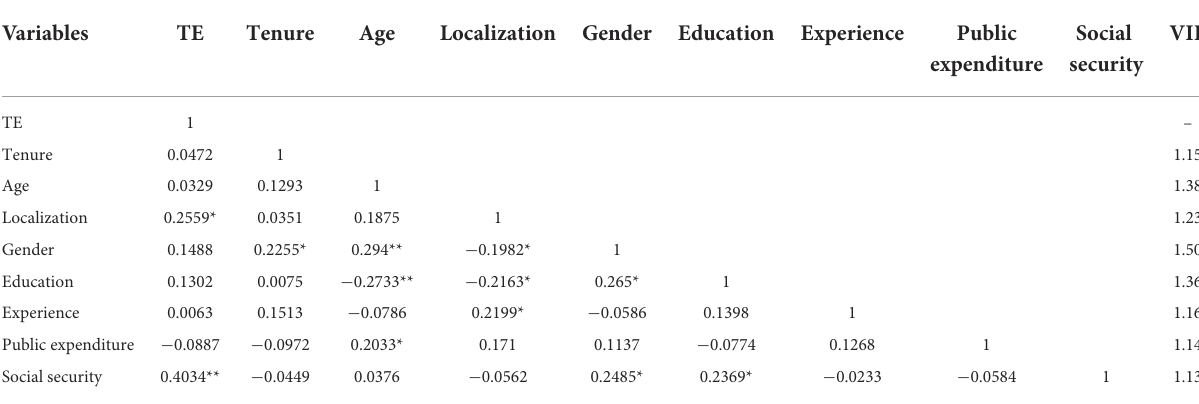
TABLE 2 Pearson correlation analysis